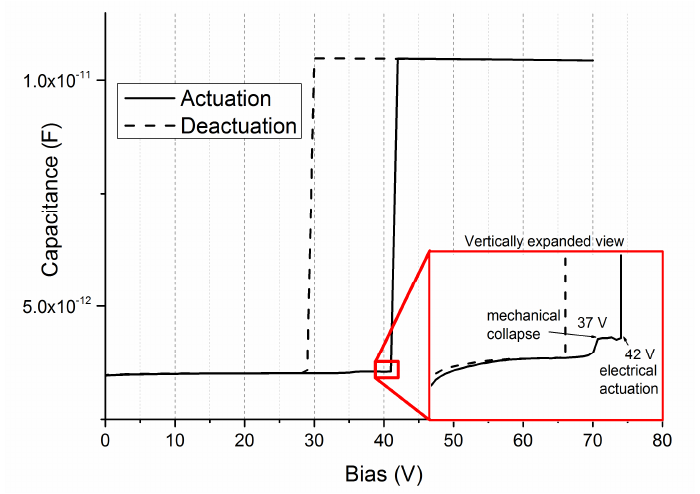
Figure 7. C–V curve of a capacitive MEMS switch. The inset reports the same curve expanded in the vertical direction. The first and the second collapse are clearly